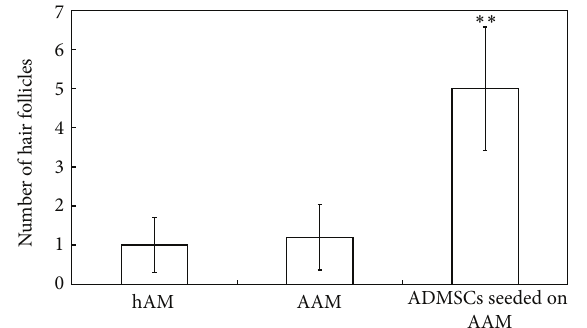
Figure 4: Comparison of hair follicles in different groups, ∗∗ 𝑃 < 0.05 . Image pro plus showed that the number of hair follicles in ADMSC-AAM seeding group was significantly higher than that in hAM and AAM